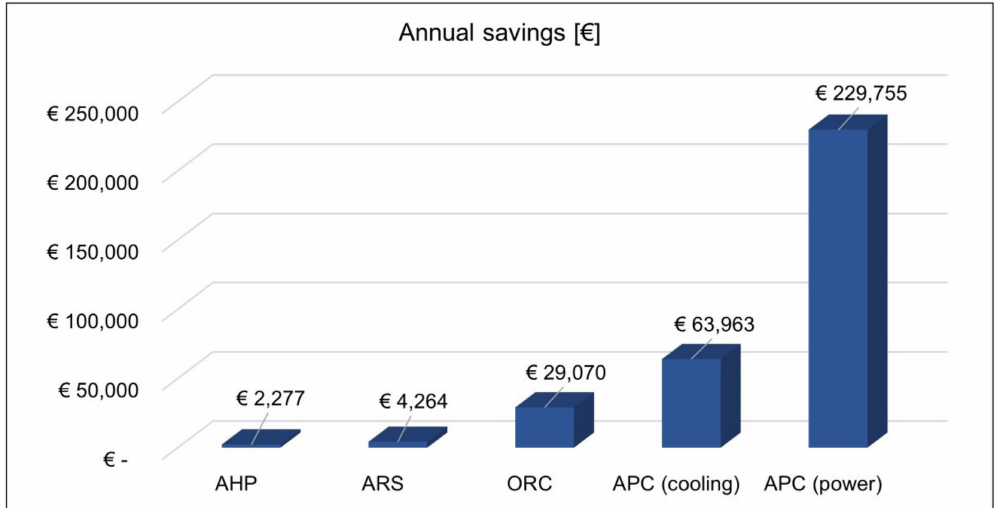
Figure 8. Potential annual savings that each technology can provide based on the data reviewed in this work and on the cost of electricity and heat foreseen within the LUT